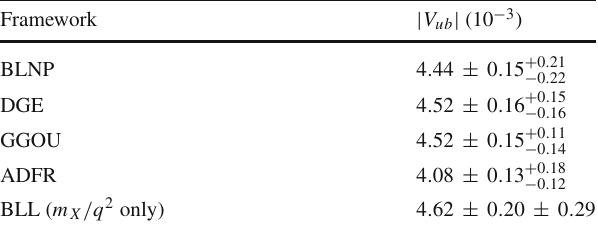
Table 91 Summary of inclusive determinations of | V ub | . The errors quotedon | V ub |